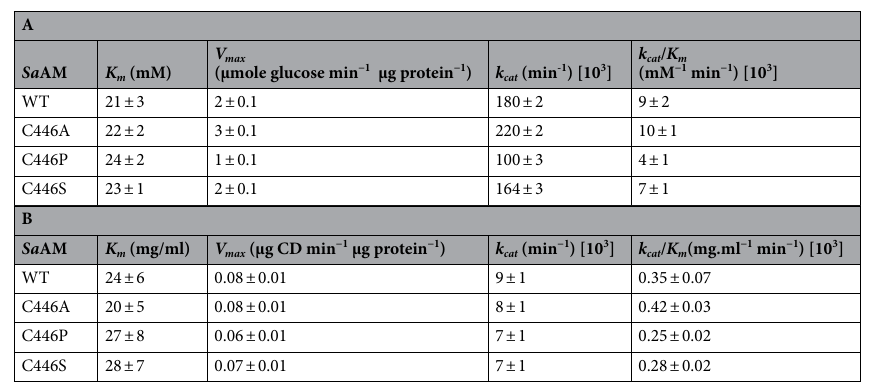
Table 4. Kinetic parameters of WT and C446 mutated Sa AMs from disproportionation reaction (A) and cyclization reaction (B). Data are shown as the mean ± standard deviation and are derived from three independent